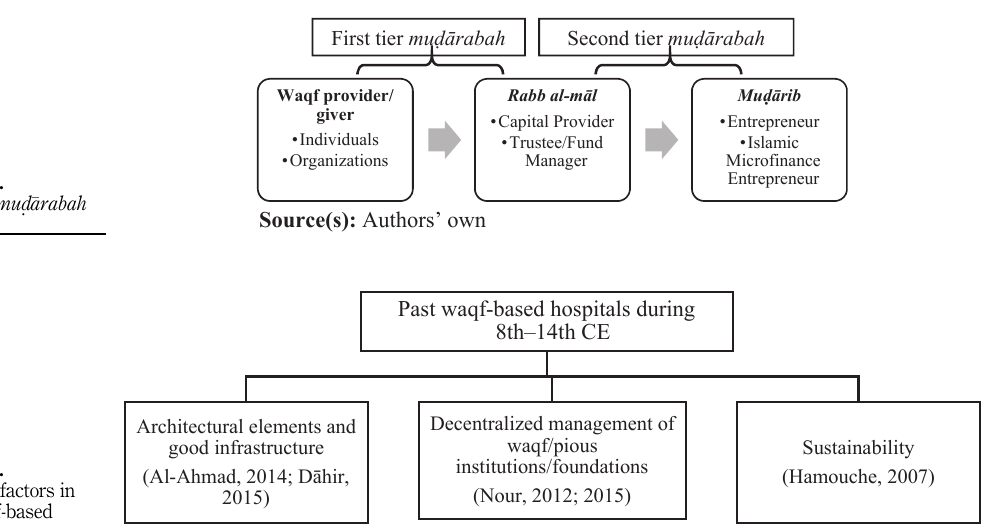
Figure 2. Essential factors in past waqf-based